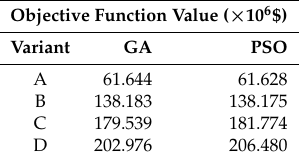
Fig. 17: Reservoir performance parameters, base on PSO optimization run. Figure 17. Reservoir performance parameters, based on the PSO optimization run. Table 3. The value of the objective function depending on the considered case; optimization of the location of multilateral wells.